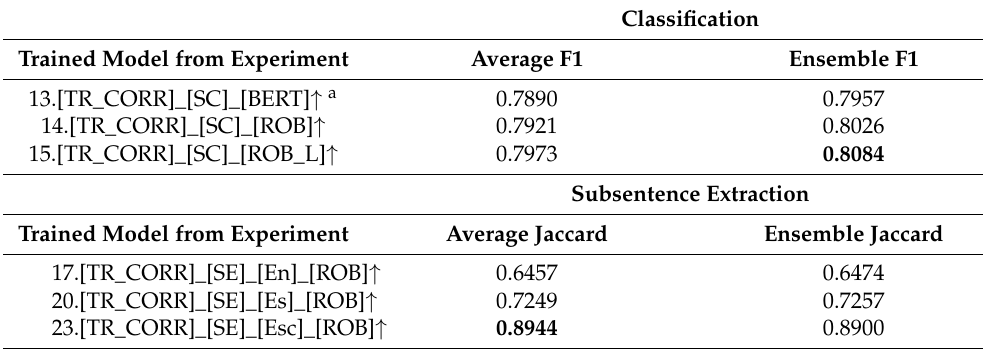
Table 7. Equally weighted ensemble result